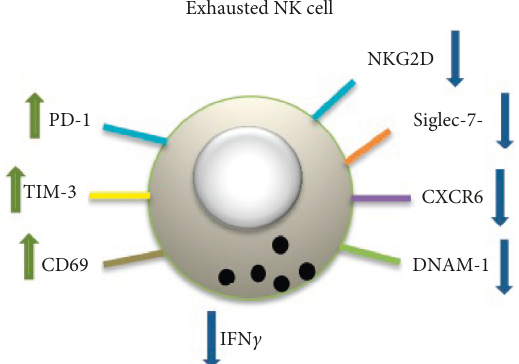
Figure 9: Schematic of exhausted NK